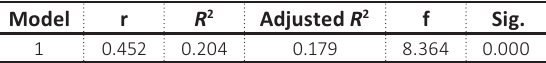
Table 6. Regressing intrapreneurship variable on the volume of production